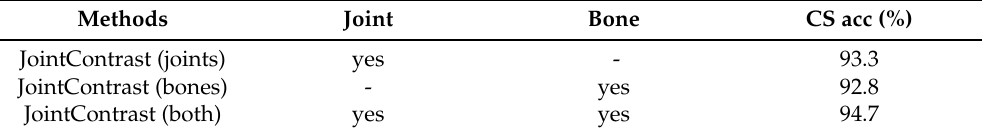
Table 7. Comparison in terms of interaction recognition accuracy of joint-, bone- and